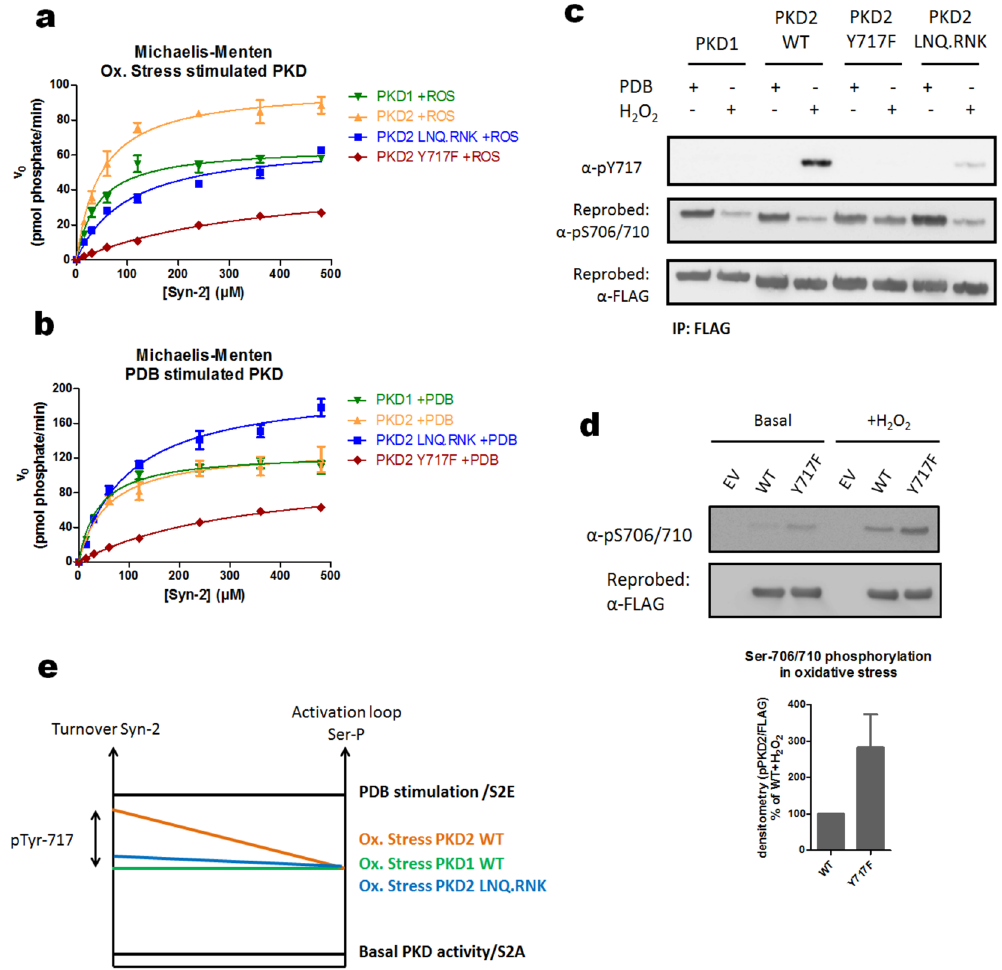
Figure 6. Oxidative stress-induced Tyr717 phosphorylation of PKD2 increases kinase activity towards syntide-2. ( a ) Kinetics of WT PKDs and the indicated mutants after activation by oxidative stress. FLAG- PKDs were purified from HEK293 cells after stimulation with H 2 O 2 (10 mM, 10 min). Protein concentration and purity (100%) was analyzed side by side by densitometry of a coomassie stained SDS-polyacrylamide gel using a BSA standard. Michaëlis-Menten kinetics for Syn-2 phosphorylation by each protein was followed in a radiometric kinase assay (see Materials and methods). ( b ) FLAG-PKDs were purified from HEK293 cells after stimulation with PDB (500 nM, 15 min). The purified proteins were subjected to the same analysis as in 6a. ( c ) Activation segment Ser and Tyr phosphorylation of stimulated enzymes. The purified enzymes described in 6a and 6b were analyzed for Ser and Tyr phosphorylation in the activation segment via Western Blotting with the indicated antibodies. Western blots were cropped for clarity; uncropped images can be found in Supplementary Fig. S22. ( d ) PKD2 Y717F displays higher activation loop Ser phosphorylation compared to PKD2 WT. HEK293 cells were transfected with wild type (WT) PKD2 or an Y717F mutant. 48 h after transfection, cells were stimulated with H 2 O 2 (10 mM, 10 min) and PKD2 was precipitated from the cells using FLAG antibody and subsequently probed for Ser-706/710 phosphorylation. Quantification of three independent experiments is shown. Western blots were cropped for clarity; uncropped images can be found in Supplementary Fig. S23. ( e ) Correlations between activation loop Ser phosphorylation and kinase activity towards peptide substrate are indicated by full lines. Pools of PKD1 and PKD2 WT enzymes harbor similar levels of activation loop Ser phosphorylation in oxidative stress, but PKD2 has higher activity towards Syn-2, which is due to Tyr-717